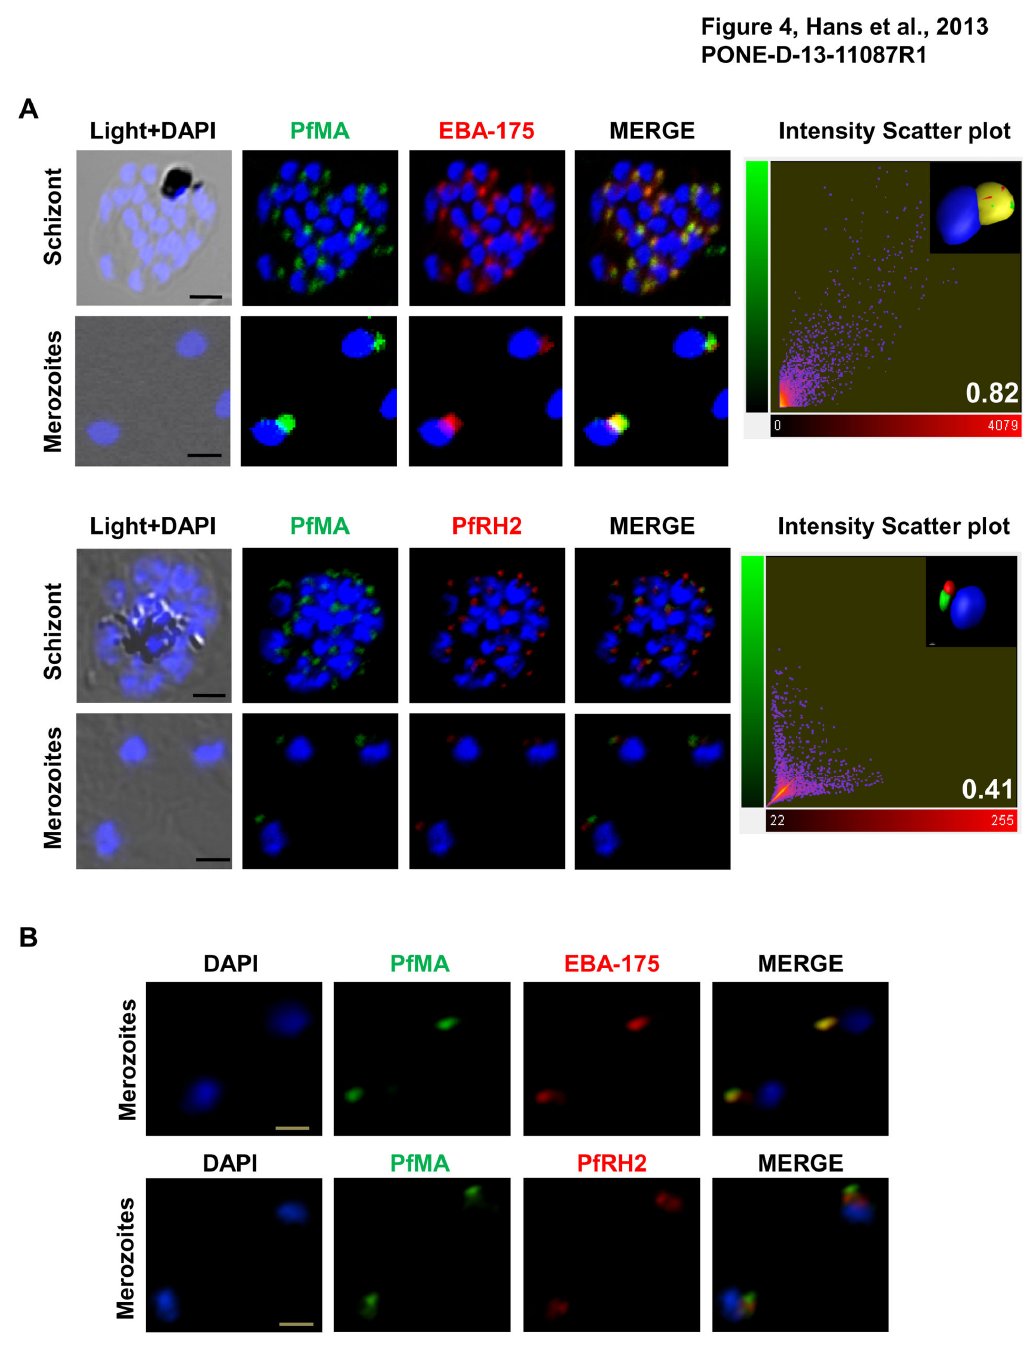
Figure 4. Micronemal localization of PfMA in merozoites analyzed by confocal and super resolution microscopy. ( A ) Co- localization of PfMA was studied with micronemal resident protein EBA-175 and rhoptry protein PfRH2 in mature schizonts and free merozoites by confocal microscopy. PfMA (green) co-localizes with EBA-175 (red) but does not co-localize with PfRH2 (red). [Scale bar 2 µm (schizont); 1µm (merozoite)]. 2D scatter plots of the voxel intensities in the red and green channels as observed for the respective images are shown in the right-hand column. The Pearson’s correlation coefficient was determined for voxel intensity correlation between the red and green channels and is displayed in the lower right-hand corner of the scatter plot. The inset image shows the snapshot of three-dimensional reconstruction of the confocal z-stack images of merozoites (scale bar 0.3 µm). ( B ) 2D Structured illumination microscopy (SIM) also showed complete co-localization between the staining of PfMA and EBA-175 and not with PfRH2, confirming its localization in the micronemes of P. falciparum merozoites. [Scale bar 1µm]. doi: 10.1371/journal.pone.0074790.g004 PLOS ONE |